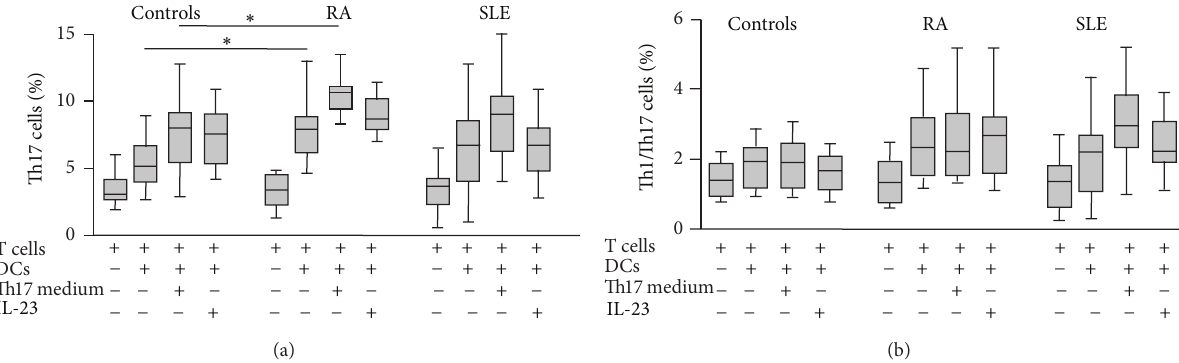
Figure 3: Induction of Th17 and Th1/Th17 lymphocytes by DCs from patients with RA and SLE. Monocyte derived DCs were cocultured with autologous CD4+ cells for five days in the presence or not of a Th17 polarizing medium (IL-1 𝛽 , IL-6, IL-21, and TNF- 𝛼 plus anti-IL-4 and anti-IFN- 𝛾 blocking antibodies) or IL-23. Then, cells were immunostained for CD4, IL-17A and IFN- 𝛾 and analyzed by flow cytometry. Data correspond to the median and interquartile range of the percent of positive cells. ∗ 𝑃 < 0.05 .